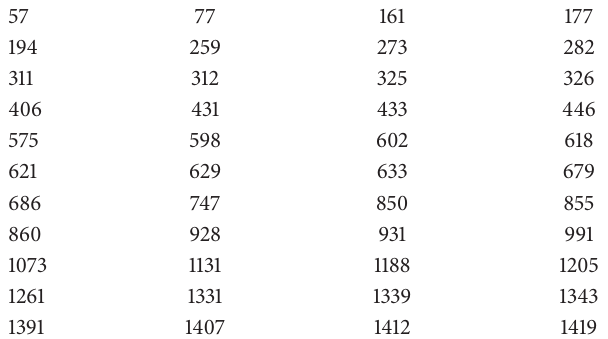
Table 5: Quality control data for the ADNI cohort. Subjects included in this table have been excluded for analysis on the basis of (A) missing, badly formatted or wrong acquisition sequence of input images; (B) poor contrast/signal-to-noise ratio; (C) failure of automated processing for the pipeline described in this paper. Note that other image processing pipelines may/may not succeed/fail for identical